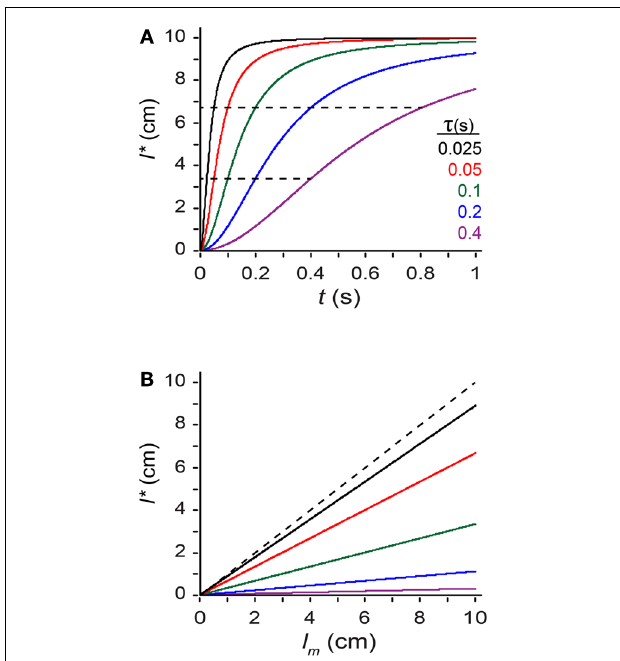
FIGURE 5 | Exploring the perceptual length contraction formula . (A) Perceived length, l *, plotted against ISI ( t ), for a trajectory of measured length l m = 10cm, at five values of the parameter τ (Eq. 2). Perceived length asymptotically approaches measured length as t increases. Each curve reaches l * = (1/3) l m (lower dashed line) when t = τ , and l * = (2/3) l m (upper dashed line) when t = 2 τ . (B) Perceived length, l *, plotted against measured length, l m , for a trajectory of t = 0.1s, at five values of τ [color code as in (A) ]. Perceived length grows linearly with, but underestimates, measured length. Observers with larger τ experience more pronounced length contraction. Dashed diagonal line: l * = l m